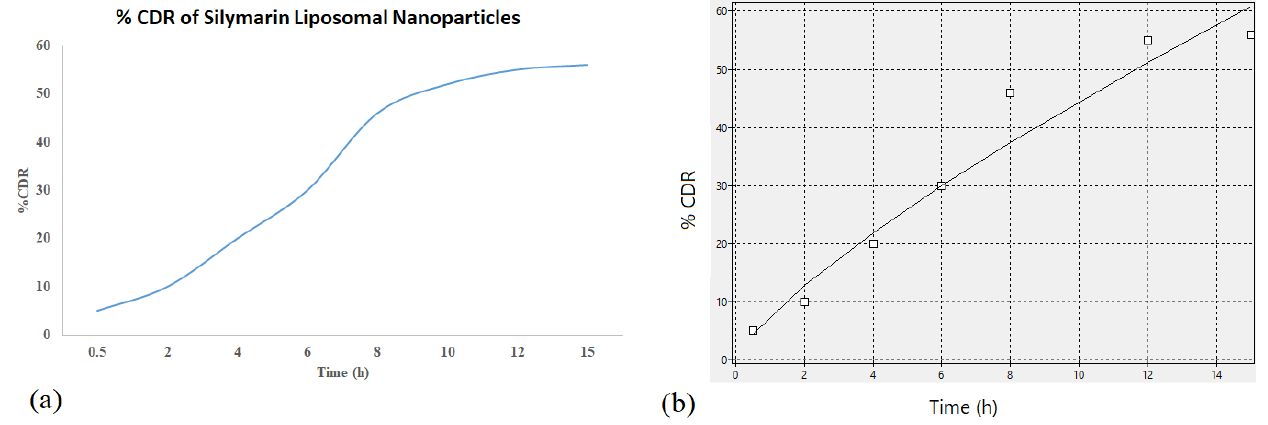
Figure 5. ( a ) Cumulative drug release of silymarin LNPs over 15 h and ( b ) curve fitting using KinetDS software to determine release model using the subplots.